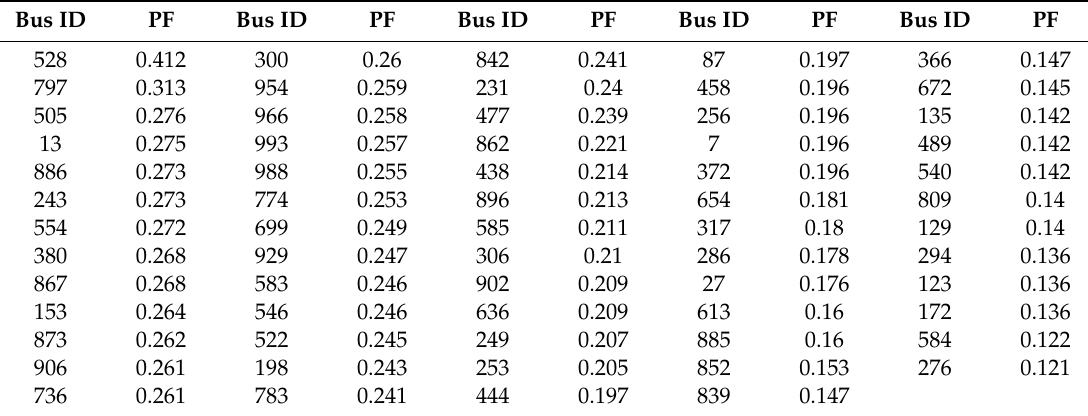
Table 2. Bus PF analysis results.